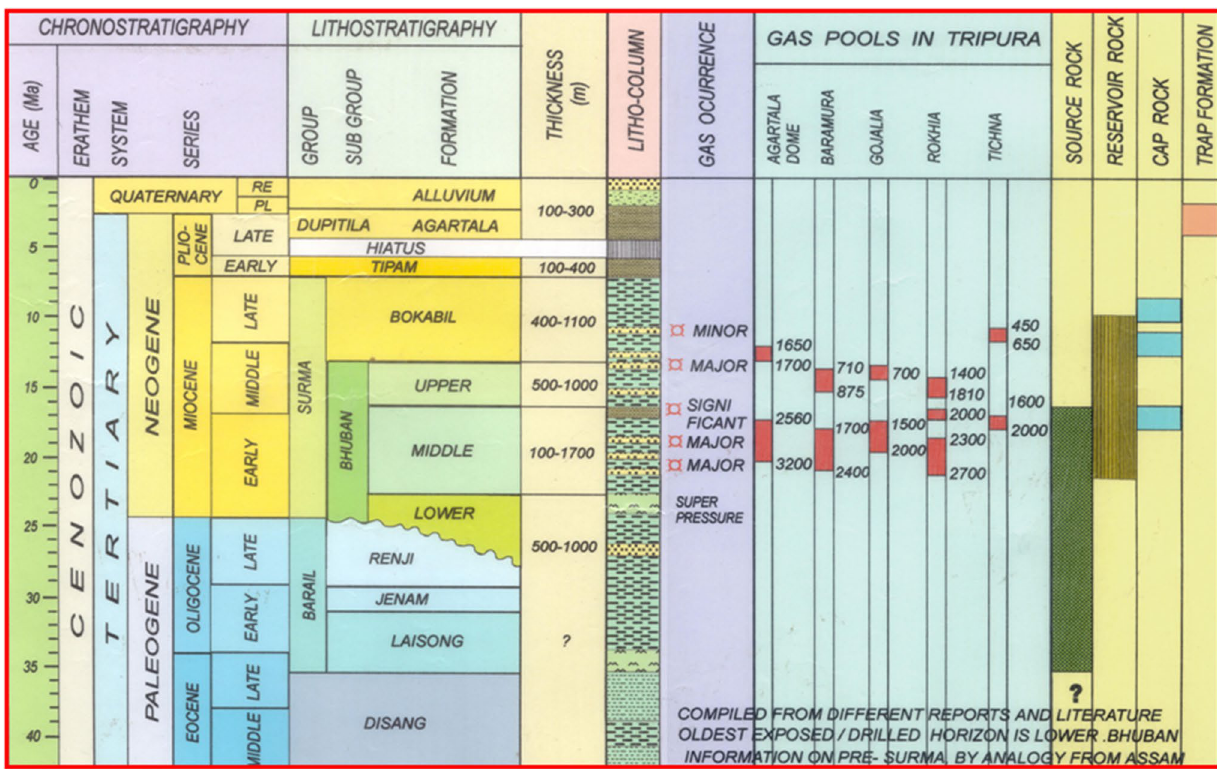
between 40 and 80 m. (After Akram et al. 2004). The gross thickness of gas pools is shown with red